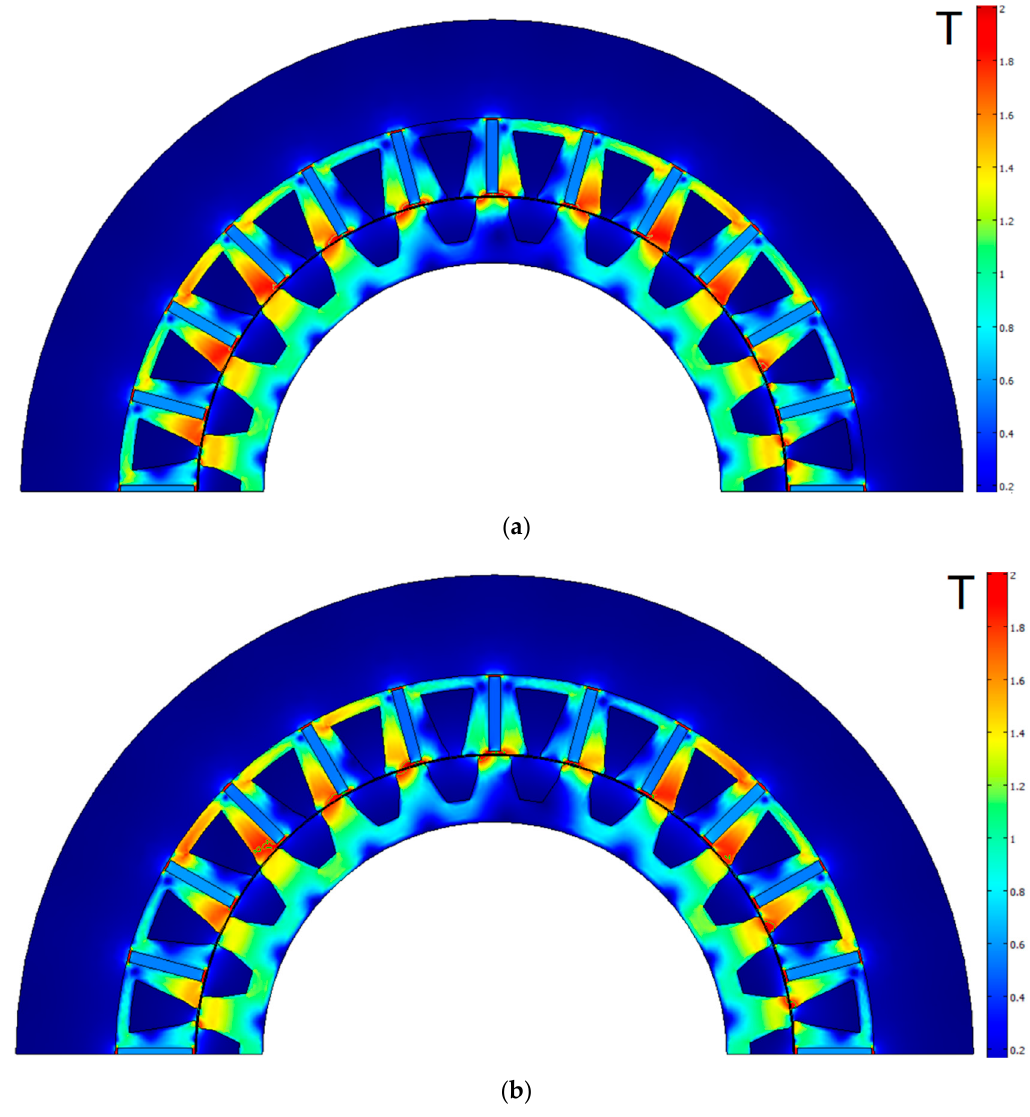
Figure 7. Flux density plot of the optimized FSG design: (a) underload mode of the two-mode profile; (b) rated mode.